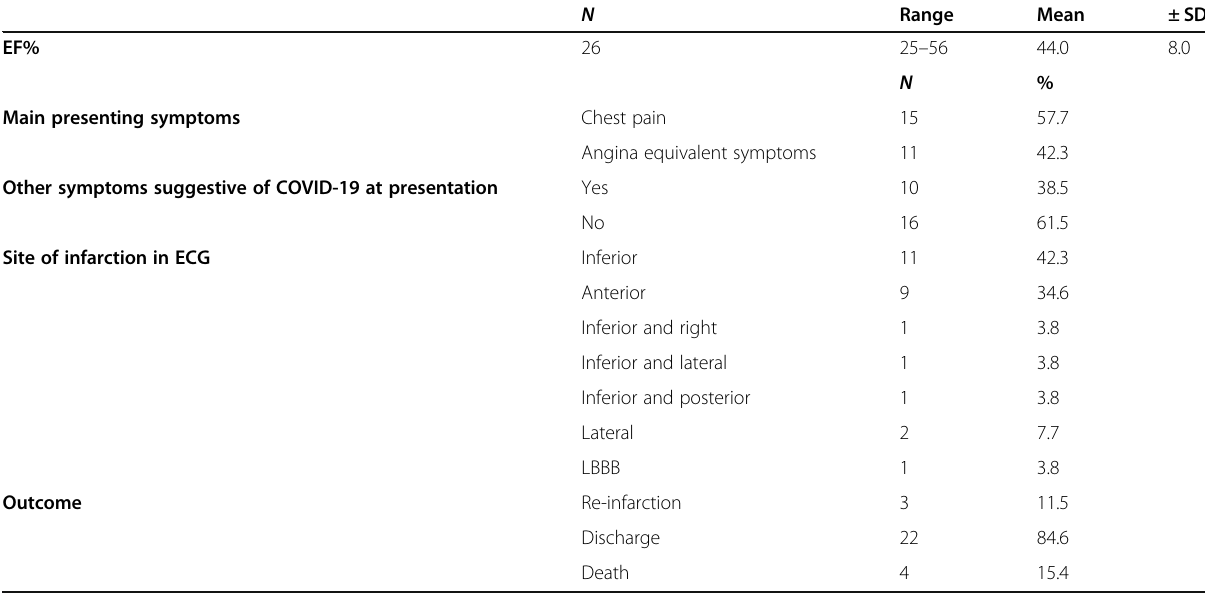
Table 2 Clinical presentation and the outcome